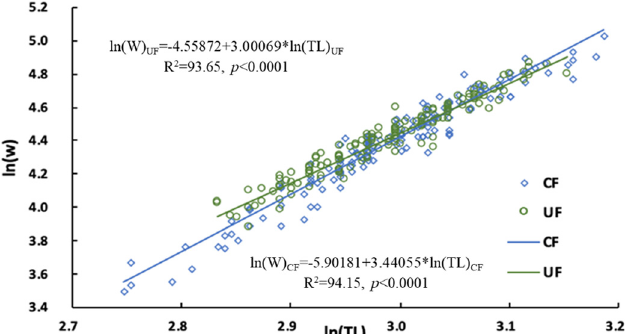
Fig. 5. Weight (W) (cid:1) total length (TL) relationships for sea bass in control RAS (CF) and Ulva -RAS (UF) groups at the end of the experimental